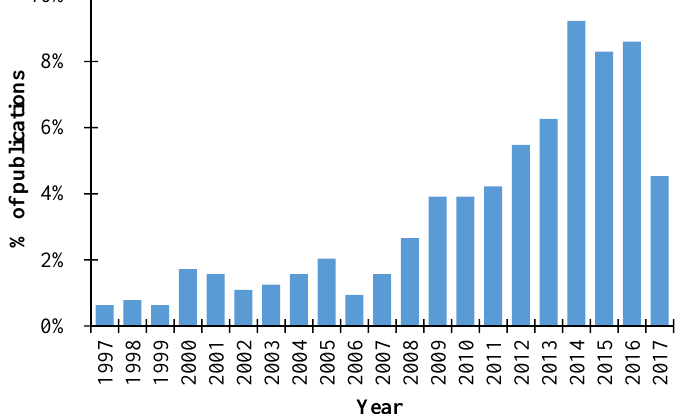
Figure 2. Percentage of publications searched by the Web of Science related to the use of renewable feedstocks for the production of polyurethane foams (PUFs) .